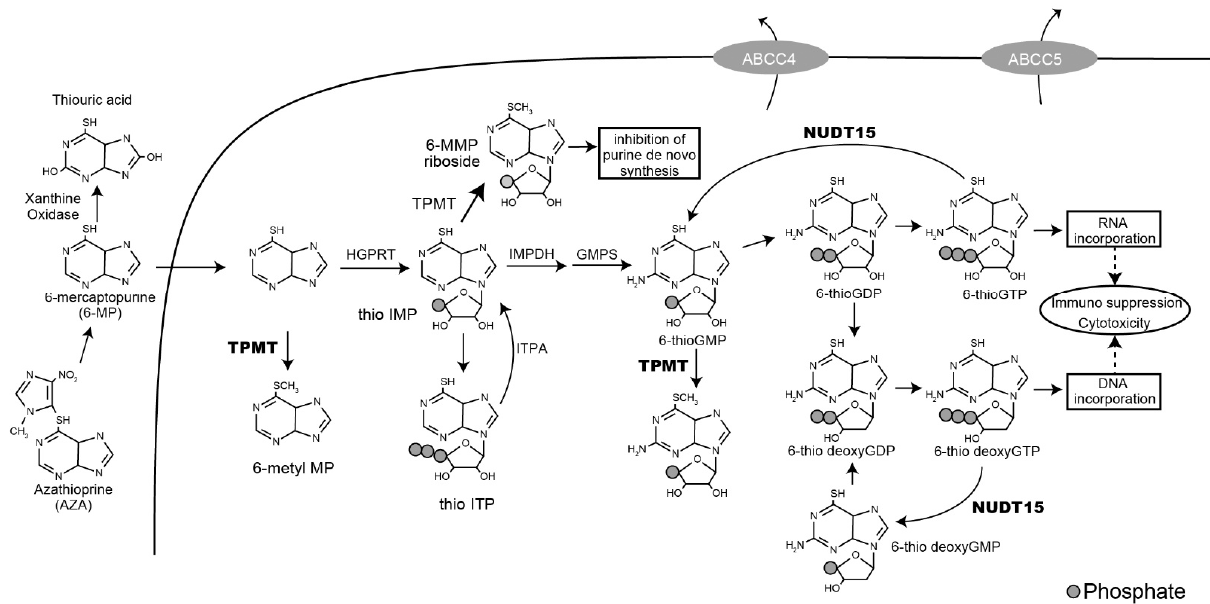
Figure 1. Thiopurine metabolism pathway. ABCC, ATP-binding cassette, subfamily C; GDP, guanosine diphosphate; GMP, guanosine monophosphate; GMPS, guanine monophosphate synthetase; GTP, guanosine triphosphate; HGPRT, hypoxanthine guanine phosphoribosyltransferase; IMP, inosine monophosphate; ITP, inosine triphosphate; IMPDH, inosine monophosphate dehydrogenase; NUDT15, nudix hydrolase 15; TPMT, thiopurine S-methyltransferase. Table 1. Clinical impact of NUDT15 alleles in Asians.